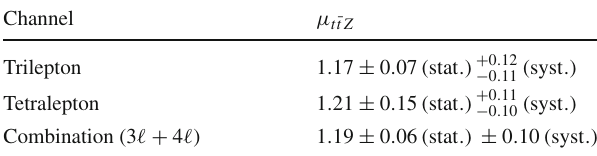
sources. The uncertainty of the theoretical prediction of the t ¯ tZ cross section (see Sect. 3) is not considered for the μ t ¯ tZ